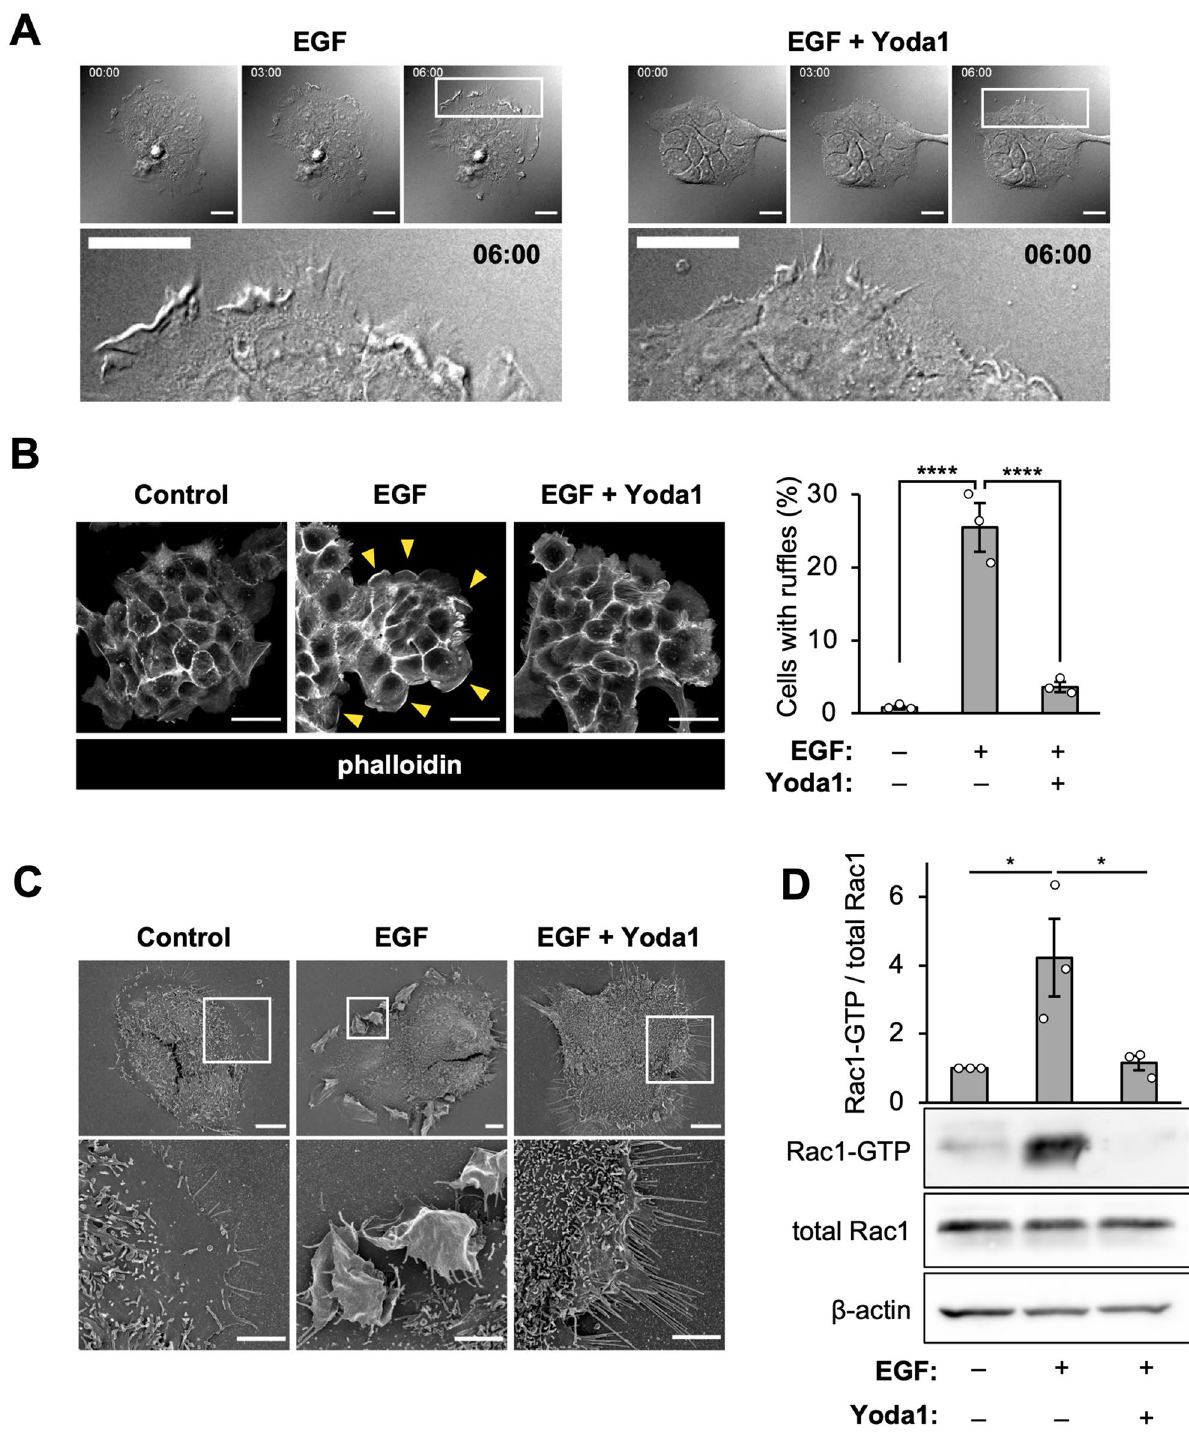
Figure 3. Piezo1 activation inhibits peripheral ruffle formation. ( A ) Live cell imaging of EGF-induced membrane ruffles in A431 cells. The cells were stimulated with EGF in the absence or presence of Yoda1 (1.5 µM). Live cell imaging was started immediately after adding EGF and Yoda1. DIC images at the indicated time points (0, 3 and 6 min) are shown. The bottom images show enlarged views of the areas outlined by the white squares in the images at 6 min. ( B ) F-actin staining with phalloidin. Left: Representative images are shown. Yellow arrowheads indicate peripheral membrane ruffling area. Right: Quantification of cells with peripheral ruffles. Data represent the mean ± s.e.m. (number of total counted cells pooled from three independent experiments: from left to right, 505, 477, and 501). ( C ) Scanning electron microscopy images of A431 cells stimulated with EGF in the absence or presence of Yoda1 (1.5 µM) for 5 min. The bottom images show enlarged views of the areas outlined by the white squares in the top images. ( D ) Rac1 activation pull-down assay. Representative western blot images and densitometric analysis of Rac1- GTP levels normalized to total Rac1 are shown (three independent experiments). ****p < 0.0001 [one-way ANOVA followed by Tukey–Kramer’s post hoc test ( B , D )]. Scale bars, ( A ) 20 µm; ( B ) 50 µm; ( C , top) 10 µm; ( C , bottom) 5